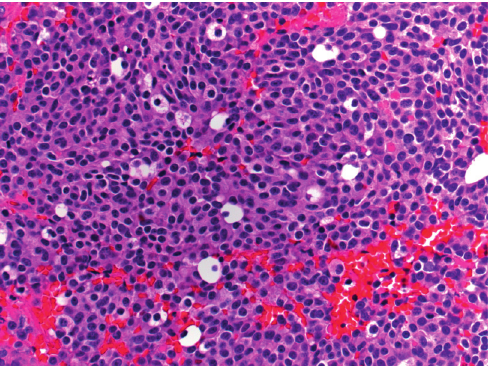
Figure 4: Permanent pathology demonstrating minimal nuclear pleomorphism and only rare mitotic figures (400x magnification).